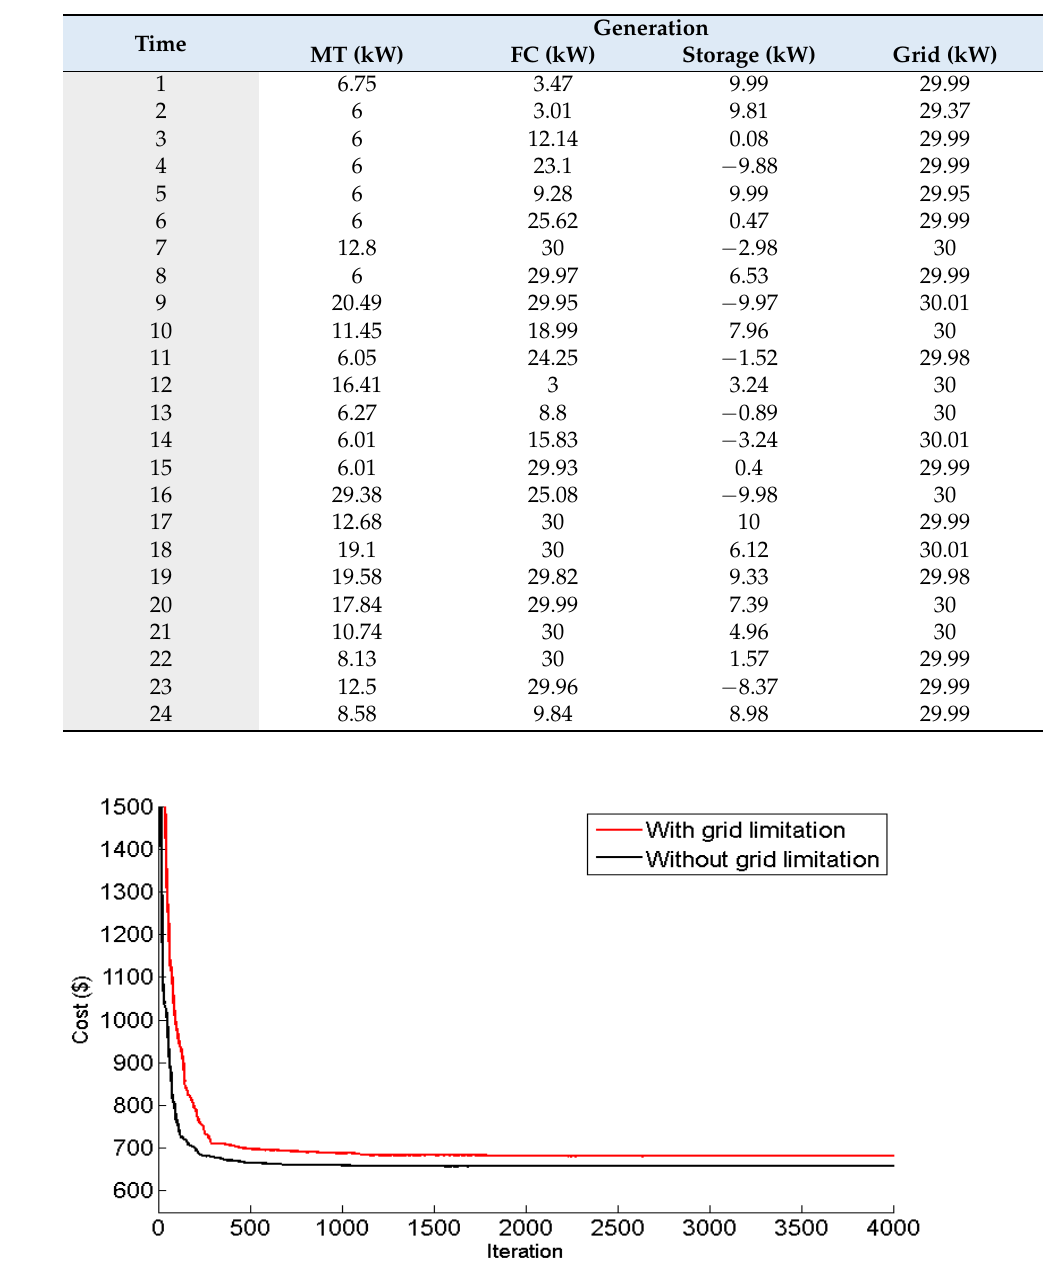
Figure 8. Comparison of cost convergence with and without the limitations of upstream power exchange. Table 17. Power distribution between generating resources to reduce costs without limitation of power exchange (total cost: $ 704.87).